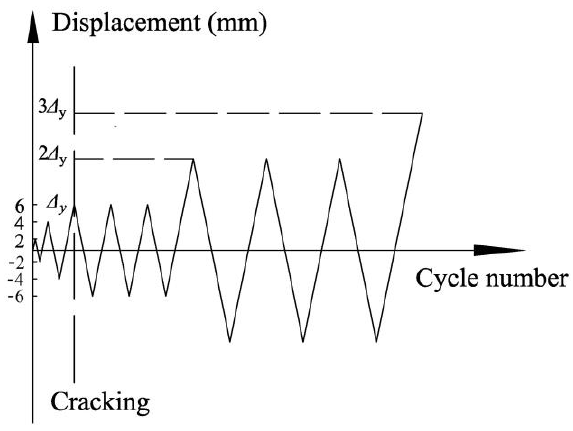
Figure 9. Loading